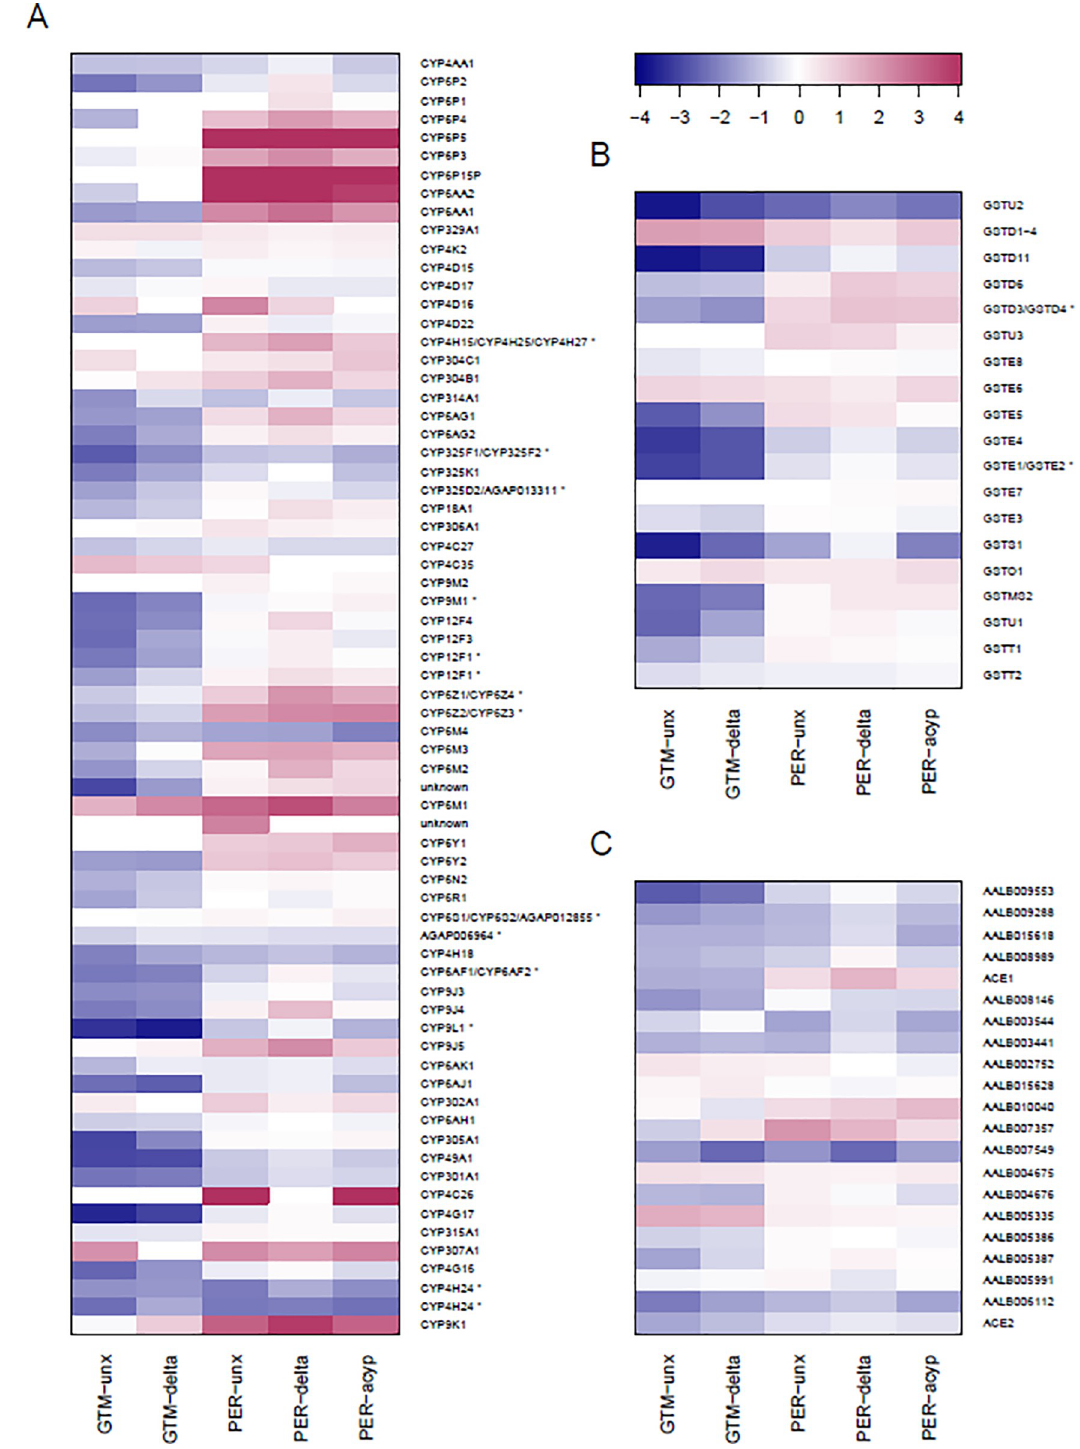
Fig 4. Heatmaps summarizing expression of detoxification genes, showing log 2 fold-change values relative to the susceptible strain Sanarate on a blue-red scale (red = overexpressed). Gene families are: (A) cytochrome P450 monooxygenases; (B) glutathione S-transferases; (C) carboxylesterases. Gene names are based on orthology to An . gambiae (an asterisk denotes ambiguous orthology). Genes on chromosome arms 2R, 2L, 3R, 3L and X are ordered from top to bottom. San = Sanarate; GTM = Guatemala; PER = Peru; unx = unexposed; delta = deltamethrin-resistant; acyp = alpha-cypermethrin-resistant.